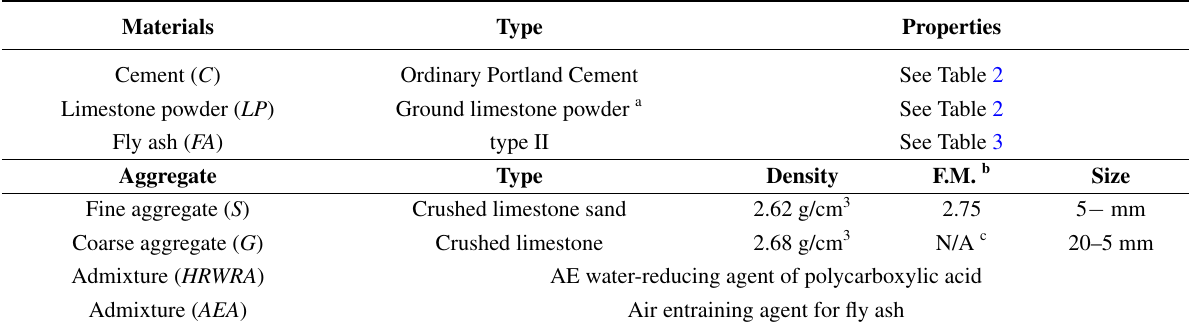
Table 1. Materials used in